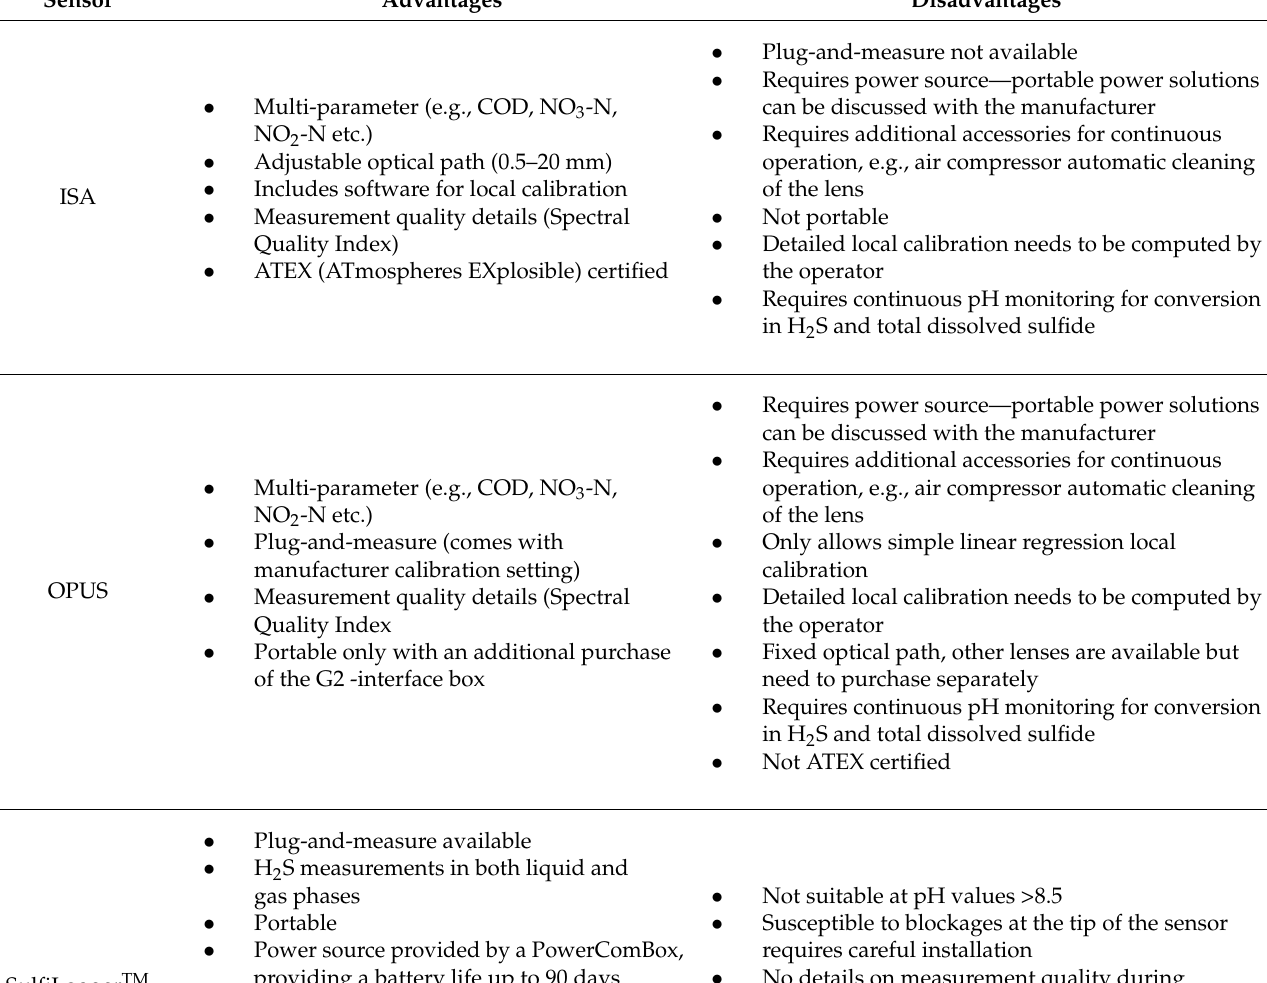
Table 3. Advantages and disadvantages of the online liquid phase H 2 S sensors used in the study.